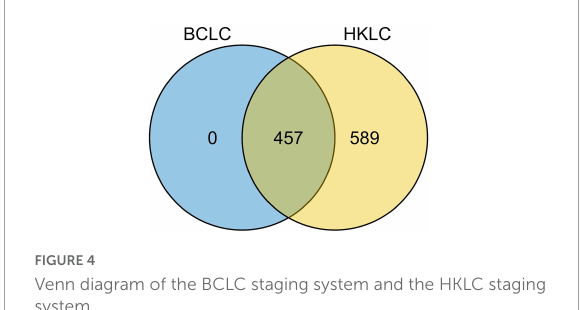
FIGURE4 Venn diagram of the BCLC staging system and the HKLC staging system.